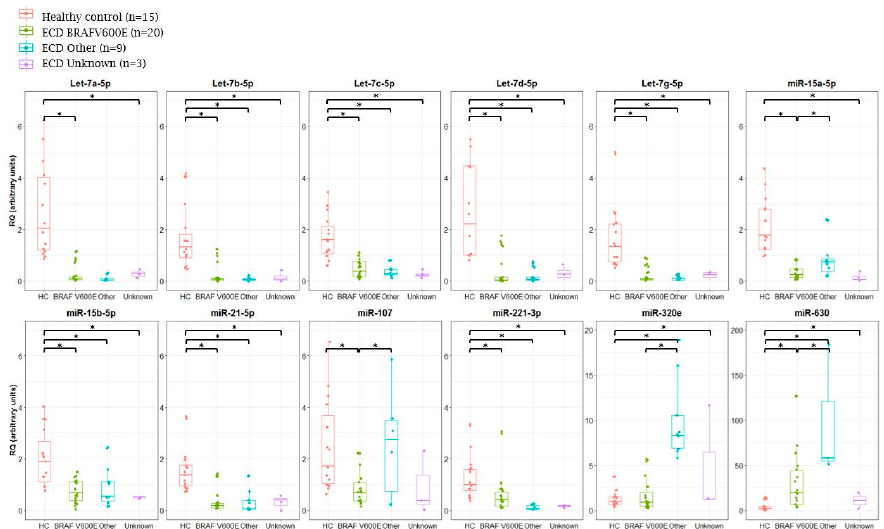
Figure 5. Analysis of miRNA expression in ECD patients by mutation type. MiRNA expression in ECD patient’s plasma samples as compared with plasma samples from healthy controls (HC) subjected to mutation analysis. “Other mutations” includes BRAF deletion and NRAS, KRAS, MAP2K2,